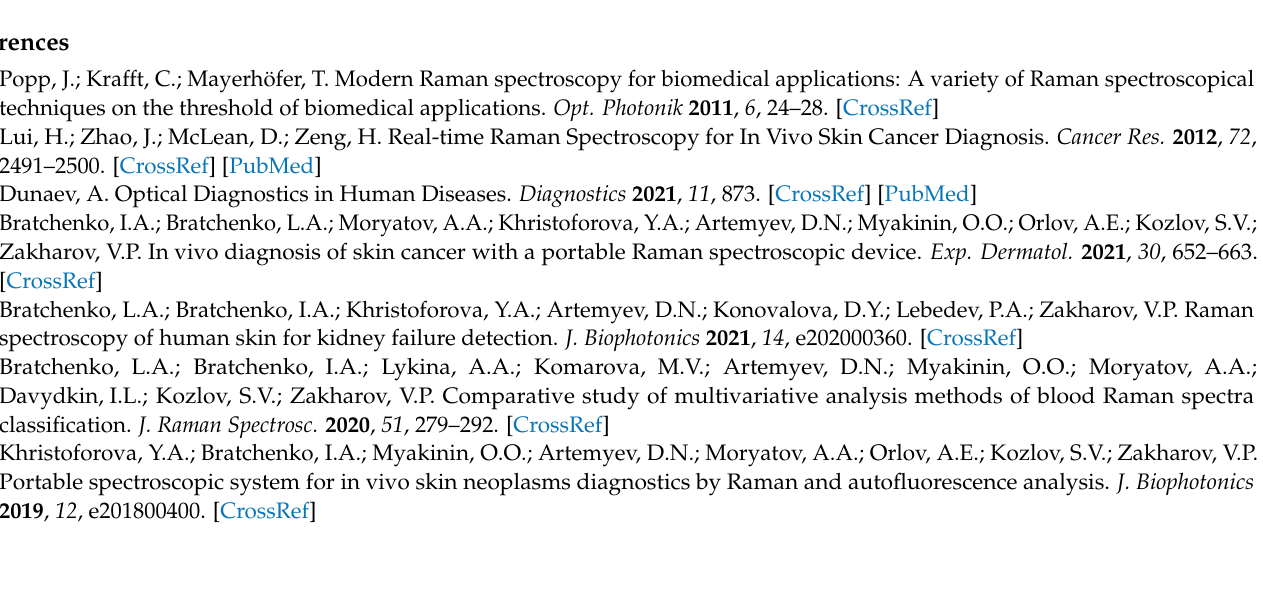
Supplementary Figure S4. Box-plot diagrams of skin component concentrations obtained by MCR analysis using a basis (B is benign neoplasms, M is malignant neoplasms, N is normal skin, BCC is basal cell carcinoma, MM is malignant melanoma, PN is pigmented